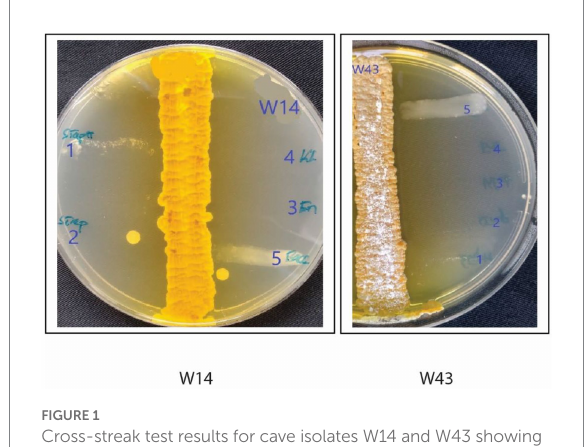
FIGURE 1 Cross-streak test results for cave isolates W14 and W43 showing zones of inhibition/antimicrobial activity, against five pathogenic bacterial strains ( Staphylococcus aureus , Streptococcus aureus , Enterococcus faecalis , Klebsiella pneumoniae , and Bacillus cereus ). Measurements (mm) for zones of inhibition for 34 isolates are given in Table 1. Supplementary Figure S2 illustrates the technique used for cross